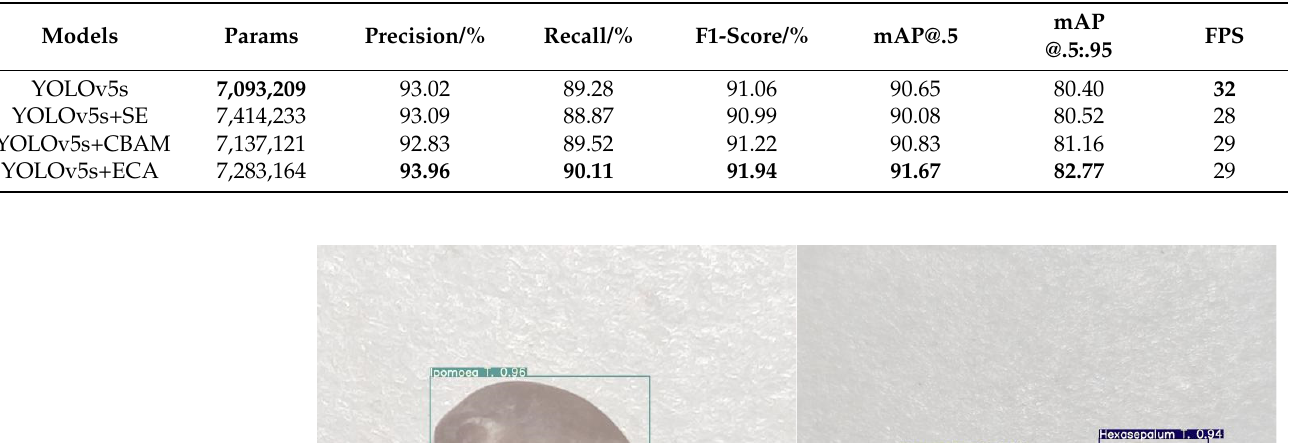
Table 5. Experimental comparison of YOLOv5s integrated attention module. Bold data represent the best result.